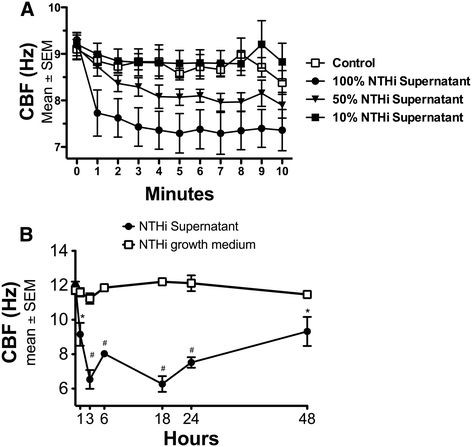
Supernatants from NTHi slow ciliary beat frequency in a time-and concentration-dependent manner.A) Bovine bronchial epithelial cells (BBECs) were exposed to 0%, 10%, 50% and 100% NTHi supernatant for 10 minutes. Ciliary beat frequency (CBF) was measured each minute. NTHi supernatant exposure rapidly slows CBF at the 50% (*p < 0.05) and 100% (#p < 0.001) concentrations. There is no difference between 10% and media control. (n = 6) B) BBECs were exposed to 50% NTHi supernatant, or 50% NTHi growth medium for up to 48 hours and CBF was measured hourly. The CBF slowing is sustained, with statistically significant CBF slowing at each timepoint compared to control. (*p < 0.05; #p < 0.001 vs. media) (n = 8).